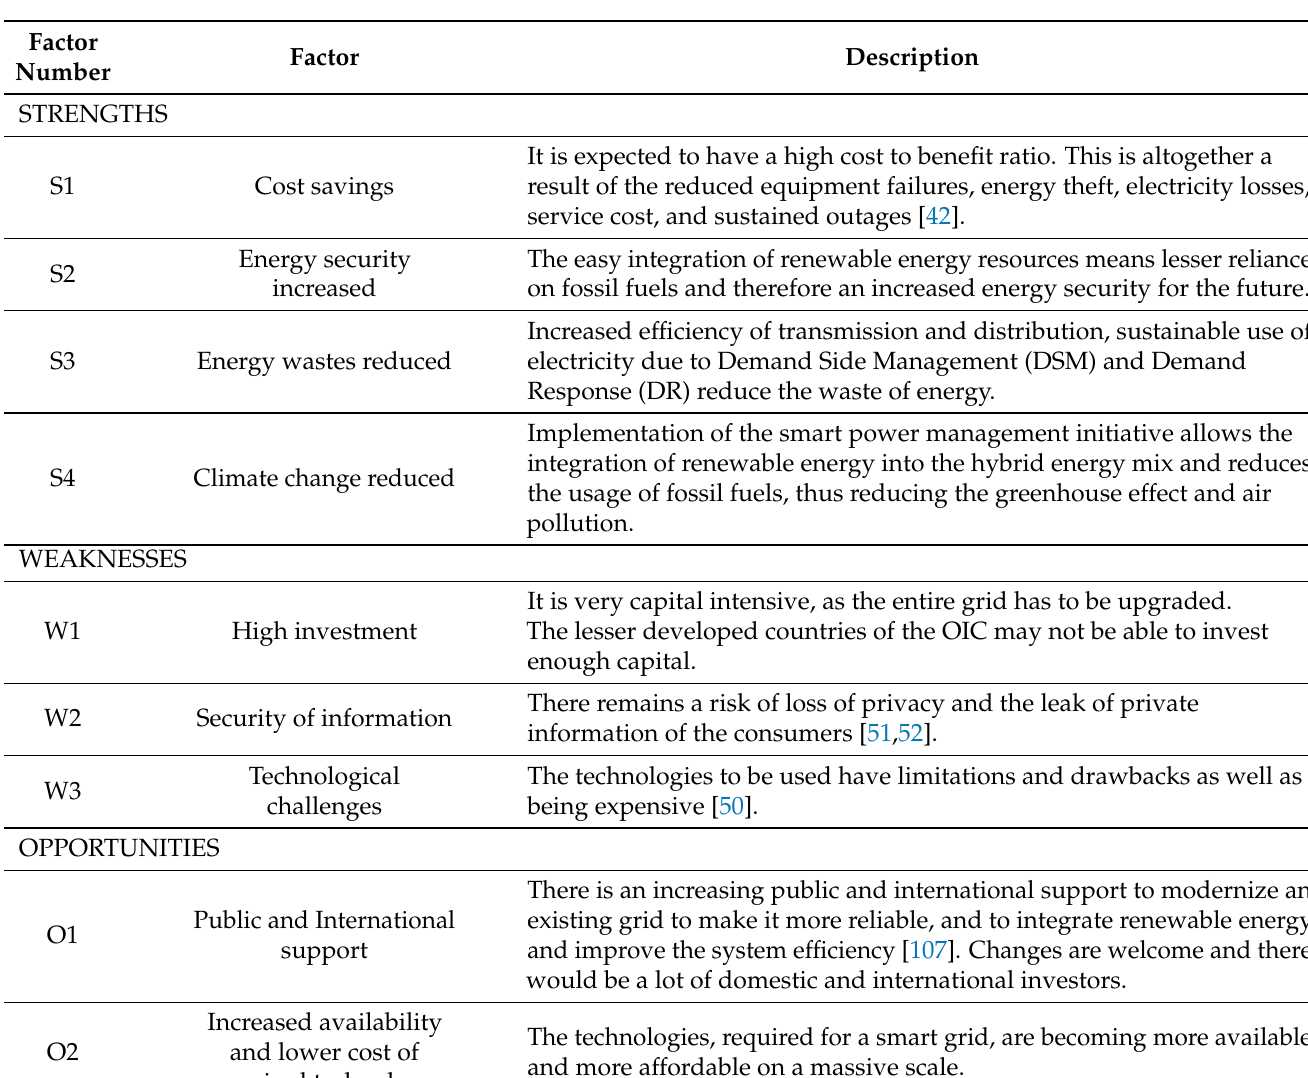
Table 9. Formation of the SWOT